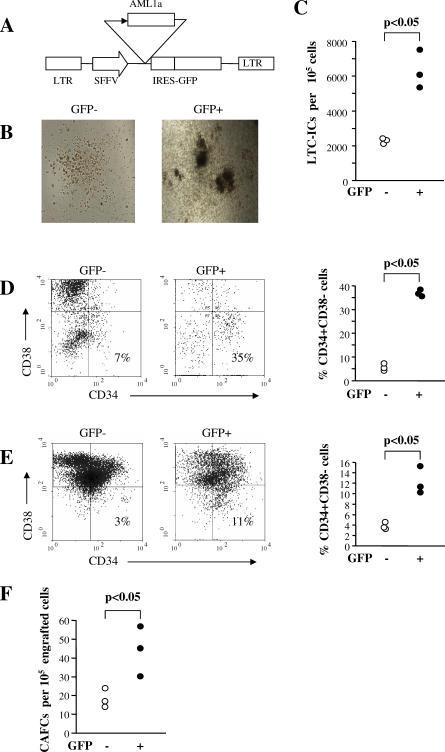
Forced Expression of AML1a in Human Cord Blood Cells(A) Lentiviral construct used for transduction.(B) Photomicrograph of typical LTC-IC colonies derived from AML1a-expressing (GFP+) and control (GFP−) human cord blood cells.(C) Frequency of LTC-IC in AML1a-expressing (GFP+) and control (GFP−) human cord blood cells.(D) Representative FACS analysis of AML1a-transduced (GFP+) and control (GFP−) cells recovered after 5 wk of culture on MS-5 stromal layers. Right plot shows graphical summary of all experiments performed.(E) Representative FACS analysis of AML1a-expressing (GFP+) and control (GFP−) human cells engrafted in the BM of NOD-SCID mice at 8 wk (left plot). Right plot shows graphical summary of all experiments performed.(F) Frequency of LTC-IC in human cells derived from primary NOD-SCID mice engrafted with AML1a-transduced cells.In (C), (D), (E), and (F), Mann-Whitney test showed statistical significance of the difference (p < 0.05).